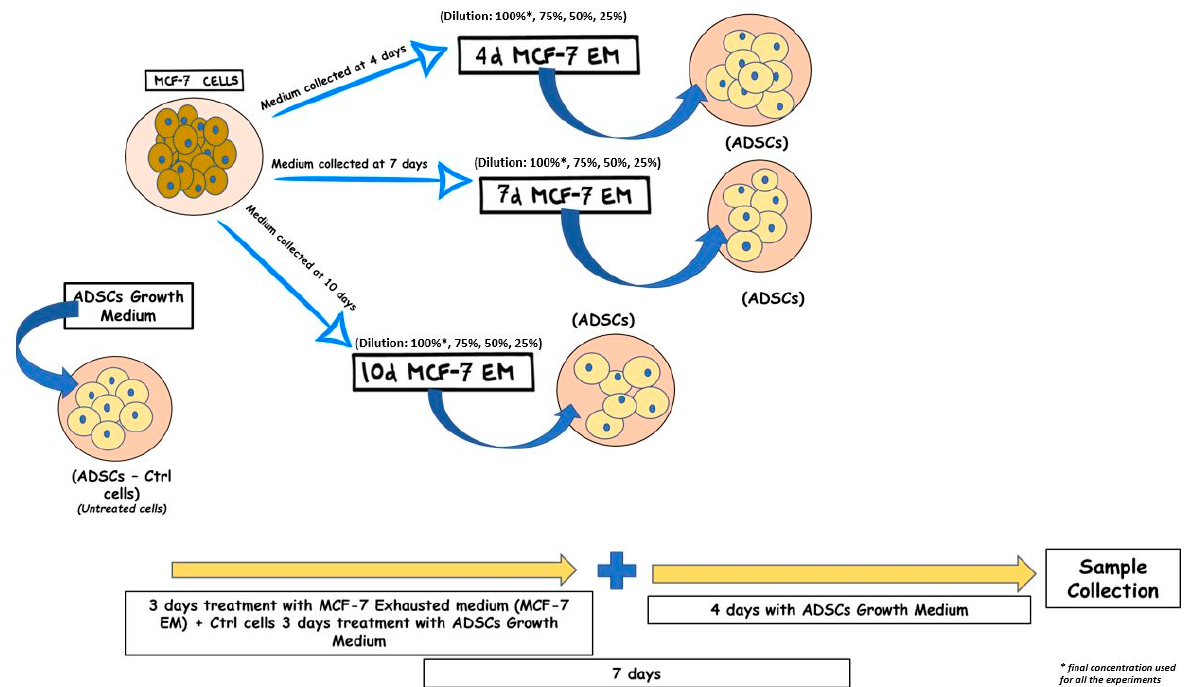
Figure 1. MCF-7 cell culturing and hADSC treatment.